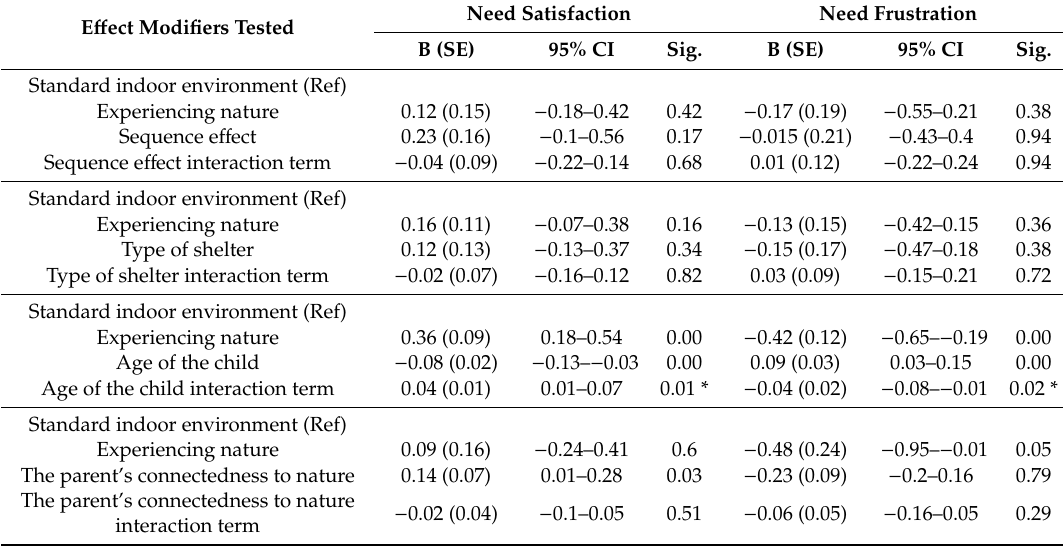
Table A2. Potential E ff ect Modifiers: Estimates of Fixed E ff ects with Standard Error, 95% Confidence Interval and